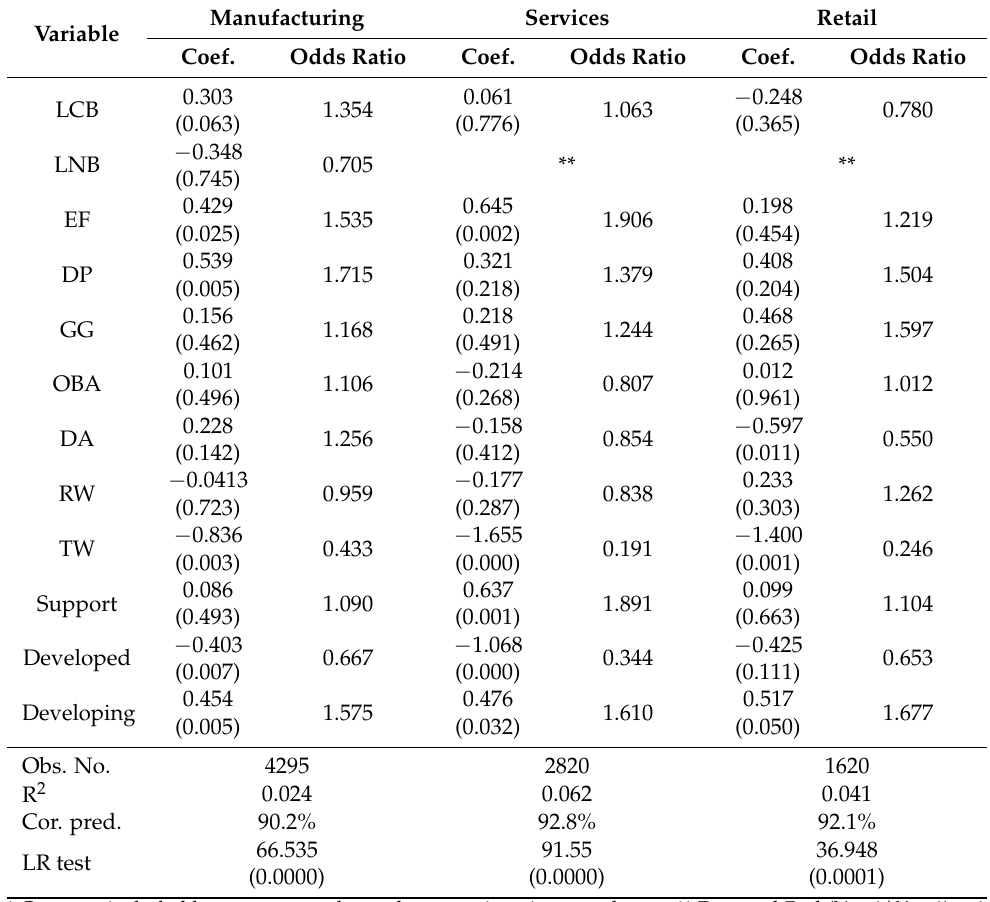
Table 5. Logit binary model’s estimation results *—sales decrease. Manufacturing Services Variable Coef.